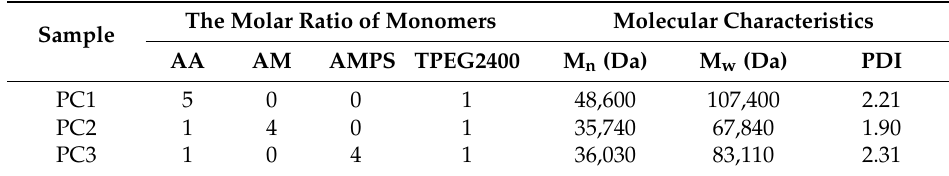
Table 2. Monomers molar ratio and molecular data of PCs.